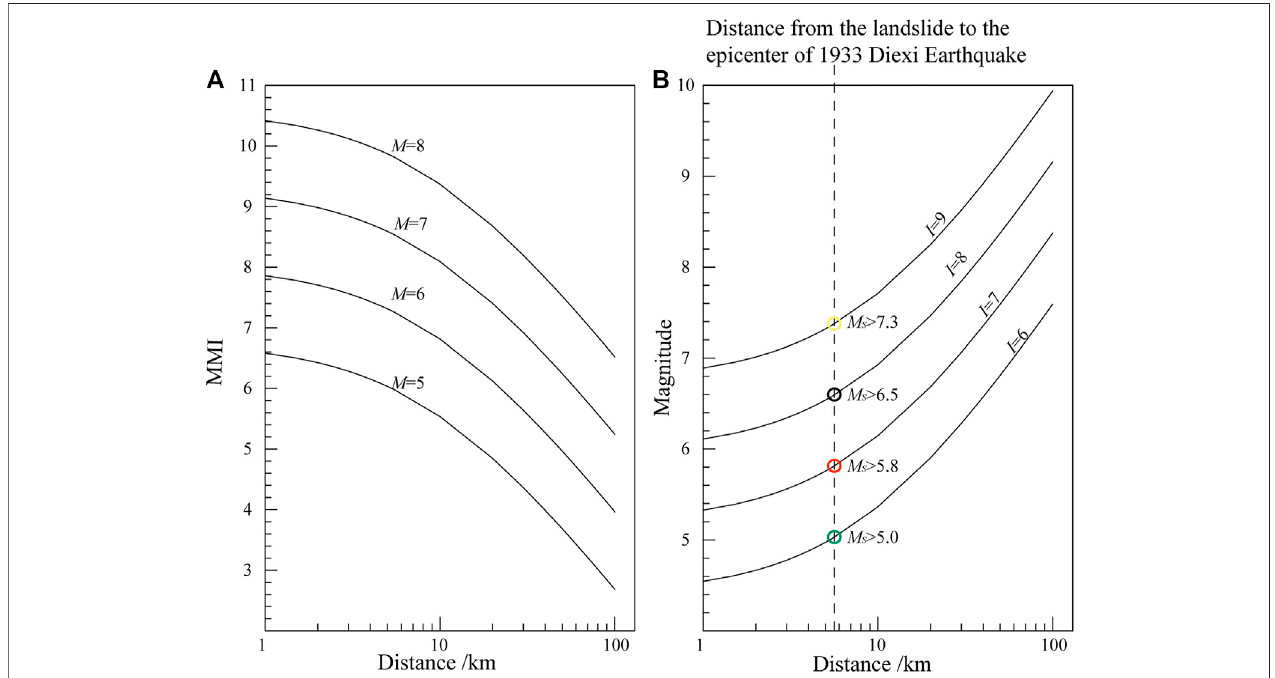
FIGURE6|(A) AttenuationmodelbyLeiet al.(2007); (B) Relationship betweenM S and RbasedondifferentMMIvalues. Thepositionofthedottedlinerepresents the distance from the section to the epicentre of the 1933 Diexi